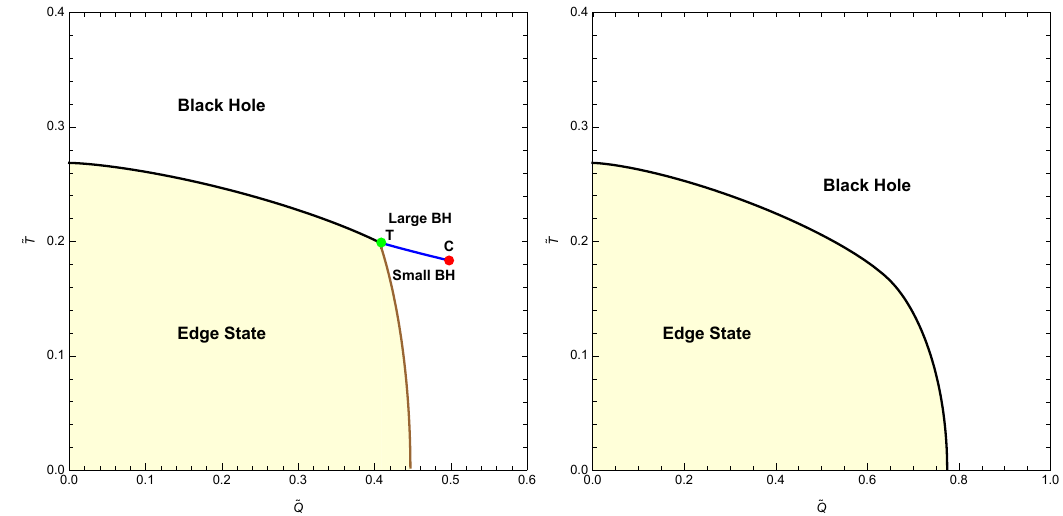
Figure 6. The phase diagrams in the ~ Q - ~ T phase space. Left Panel : ~ a = 0 : 05 < ~ a c . The (cid:12)rst- order phase transition line separating Large BH and Small BH is displayed by the blue line, and it terminates at the critical point, marked by the red dot and annotated by C. There are also a (cid:12)rst-order phase transition line between BH and the edge state, depicted by the black line, and a (cid:12)rst-order phase transition line between SBH and the edge state, depicted by the brown line. These (cid:12)rst-order phase transition lines merge together at the tricritical point, marked by the green dot and annotated by T. Right Panel : ~ a = 0 : 15 > ~ a c . There is a (cid:12)rst-order phase transition line separating BH and the edge state, displayed by the black